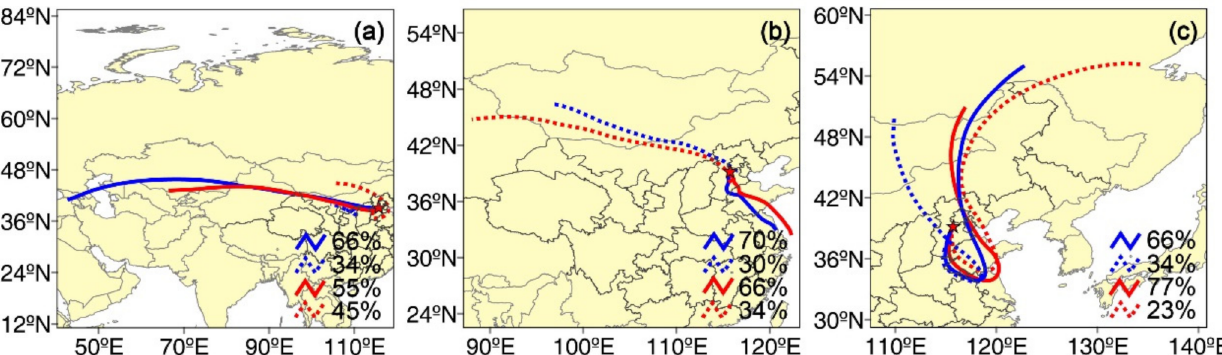
Figure 1. Cluster analysis of 120-h air mass backward trajectories initialized at 500 m (red) and 1500 m (blue). ( a ) Case of dust aerosol from 7:00 on 31 March to 22:00 on 2 April, ( b ) case of anthropogenic aerosol from 14:00 on 3 July to 21:00 on 6 July, and ( c ) case of polluted dust from 17:00 on 1 November to 23:00 on 3 November. The numbers in the bottom left are the fraction of each category of air mass backward trajectories. The 120-h air mass backward trajectories (AMBTs) were computed using the hybrid single-particle Lagrangian integrated trajectory (HYSPLIT) model of the National Oceanic and Atmospheric Administration [28]. We calculated the hourly AMBTs during the whole observation period initialized at 500 m and 1500 m. Then, cluster analysis of AMBTs was conducted in two categories directions. Base map is from TrajStat